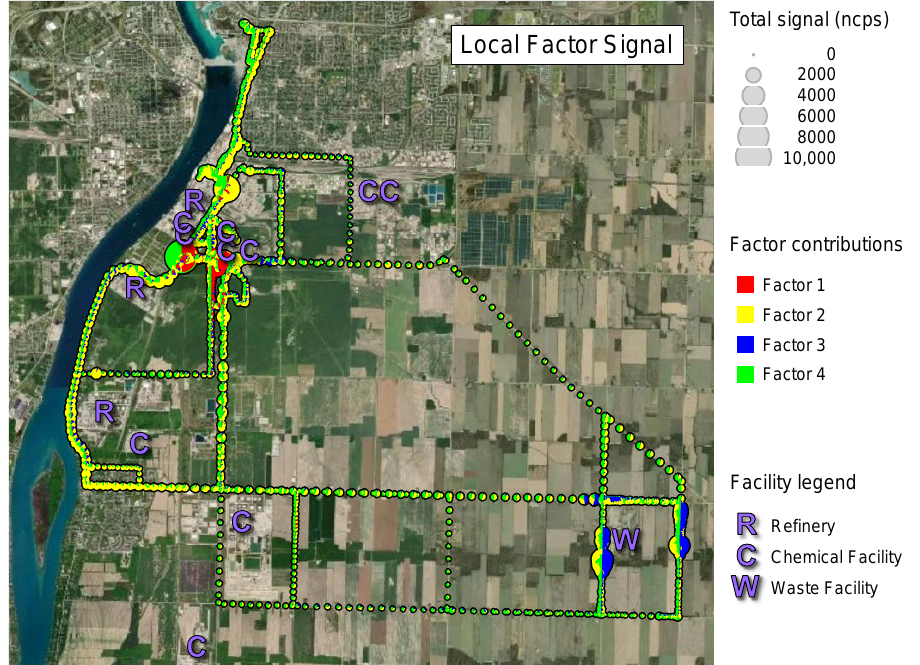
Figure 3. Relative PTR-ToF-MS signal contributions of each of the four local factors as a function of measurement location while mobile. The diameter of each pie denotes the total summed signal of the four local factors for a given measurement period and the size of each wedge within each pie represents the relative contribution of each factor for that measurement period.